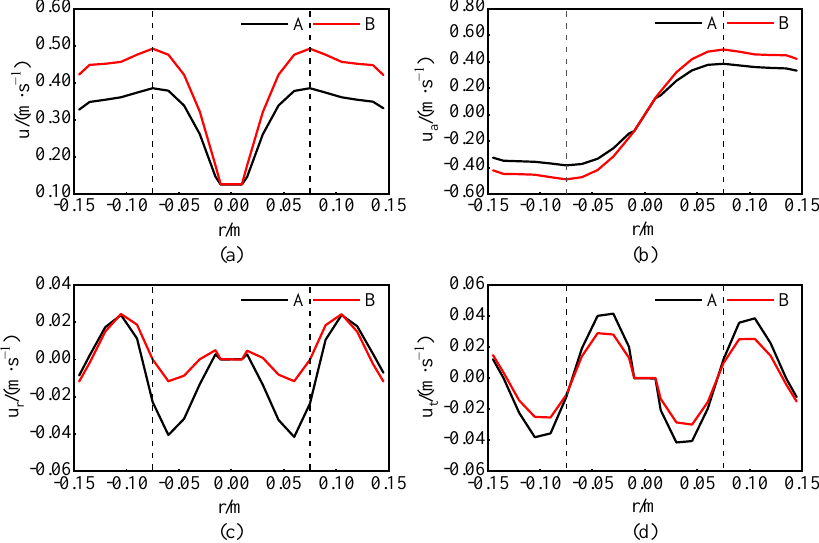
Figure 14. Velocity distribution at the axial position y = 120 mm when the medium is water and Re = 44,910. The distance between the two curves is the nominal diameter of the blade. ( a ) Total speed comparison; ( b ) Axial velocity comparison; ( c ) Radial velocity comparison; ( d )Tangential velocity comparison.